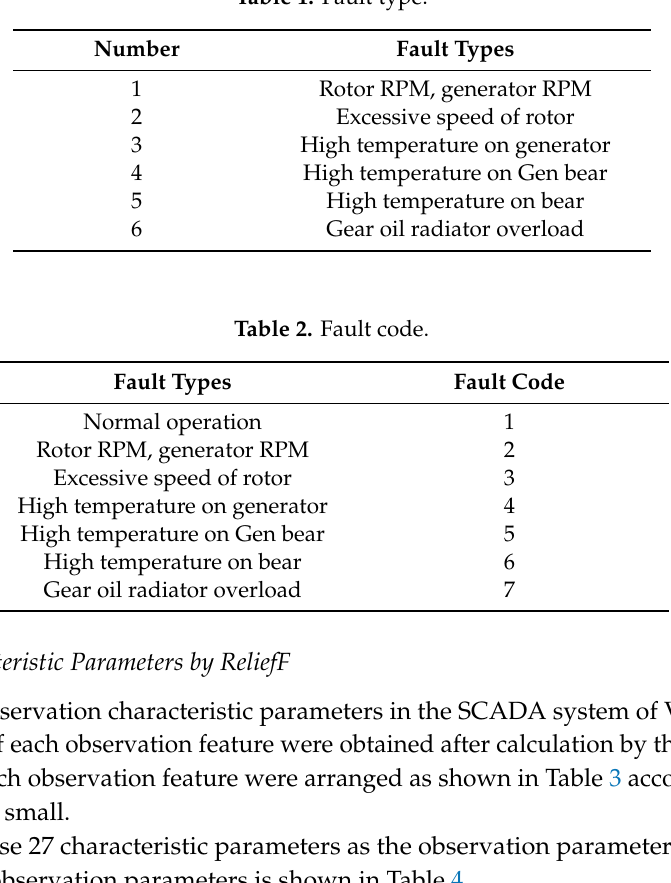
Table 1. Fault type.